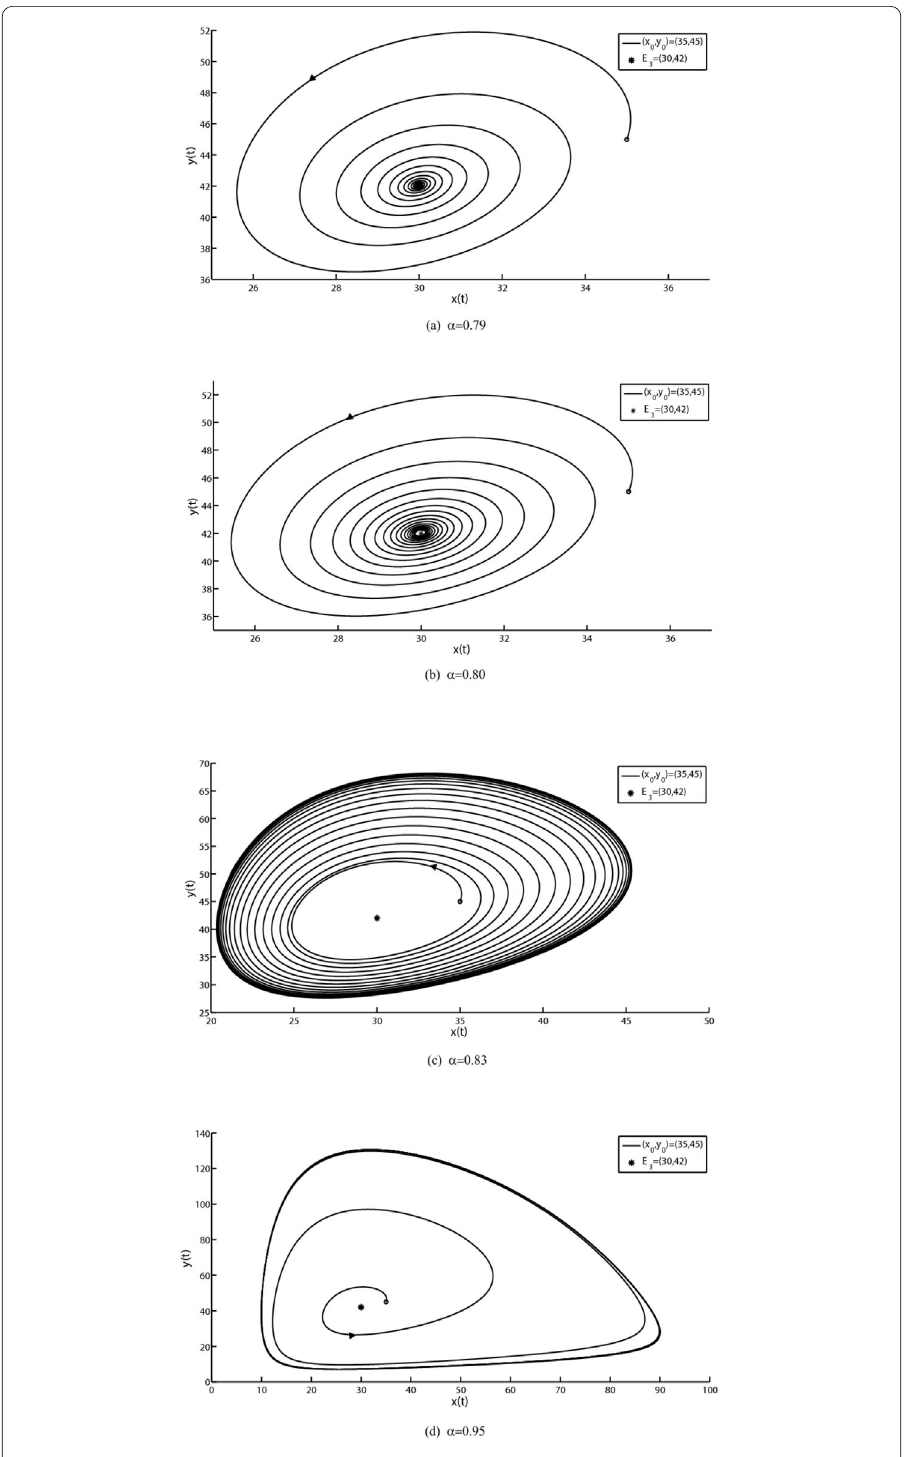
Figure 4 Effect of the derivative order α on the dynamic behavior of model (3) with the following parameters: s = 0.56, r = 0.02, K = 100, m = 2, a = 30, p = 1, and c = 0.5. ( a ) Derivative order α = 0.79, ( b ) derivative order α = 0.80, ( c ) derivative order α = 0.83, and ( d ) derivative order α =